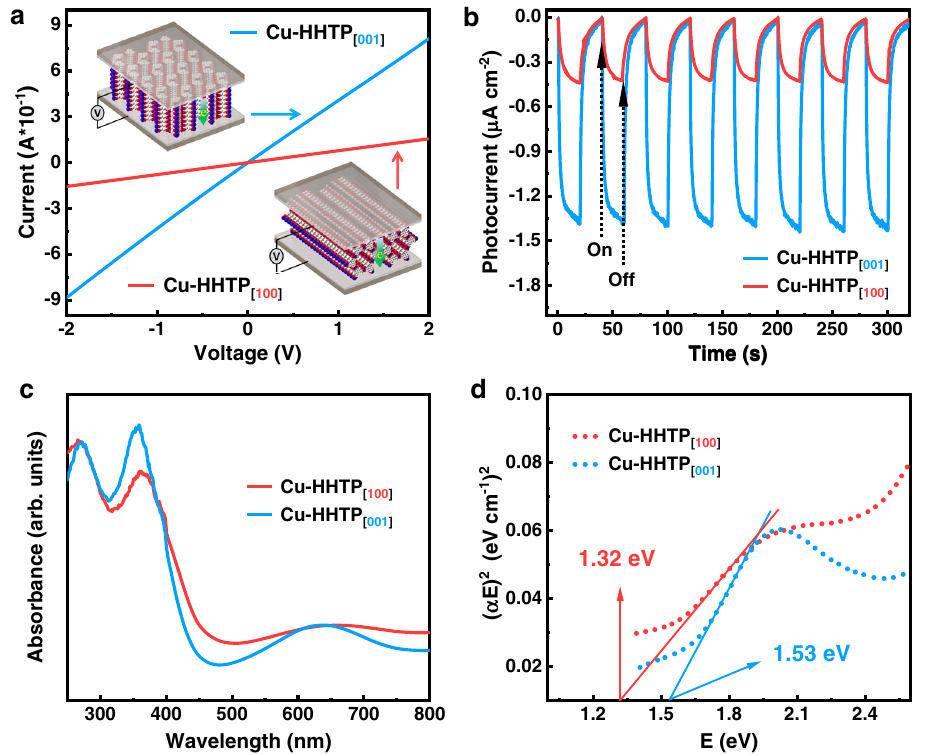
Fig.3|PhotoelectrochemicalcharacterizationofCu-HHTP fi lms.a I – V characteristicswiththeverticaldevices. b Photocurrentproperties. c UV-visspectraand d Tauc plot of Cu-HHTP [001] and Cu-HHTP [100] fi lms. arb. units: arbitrary